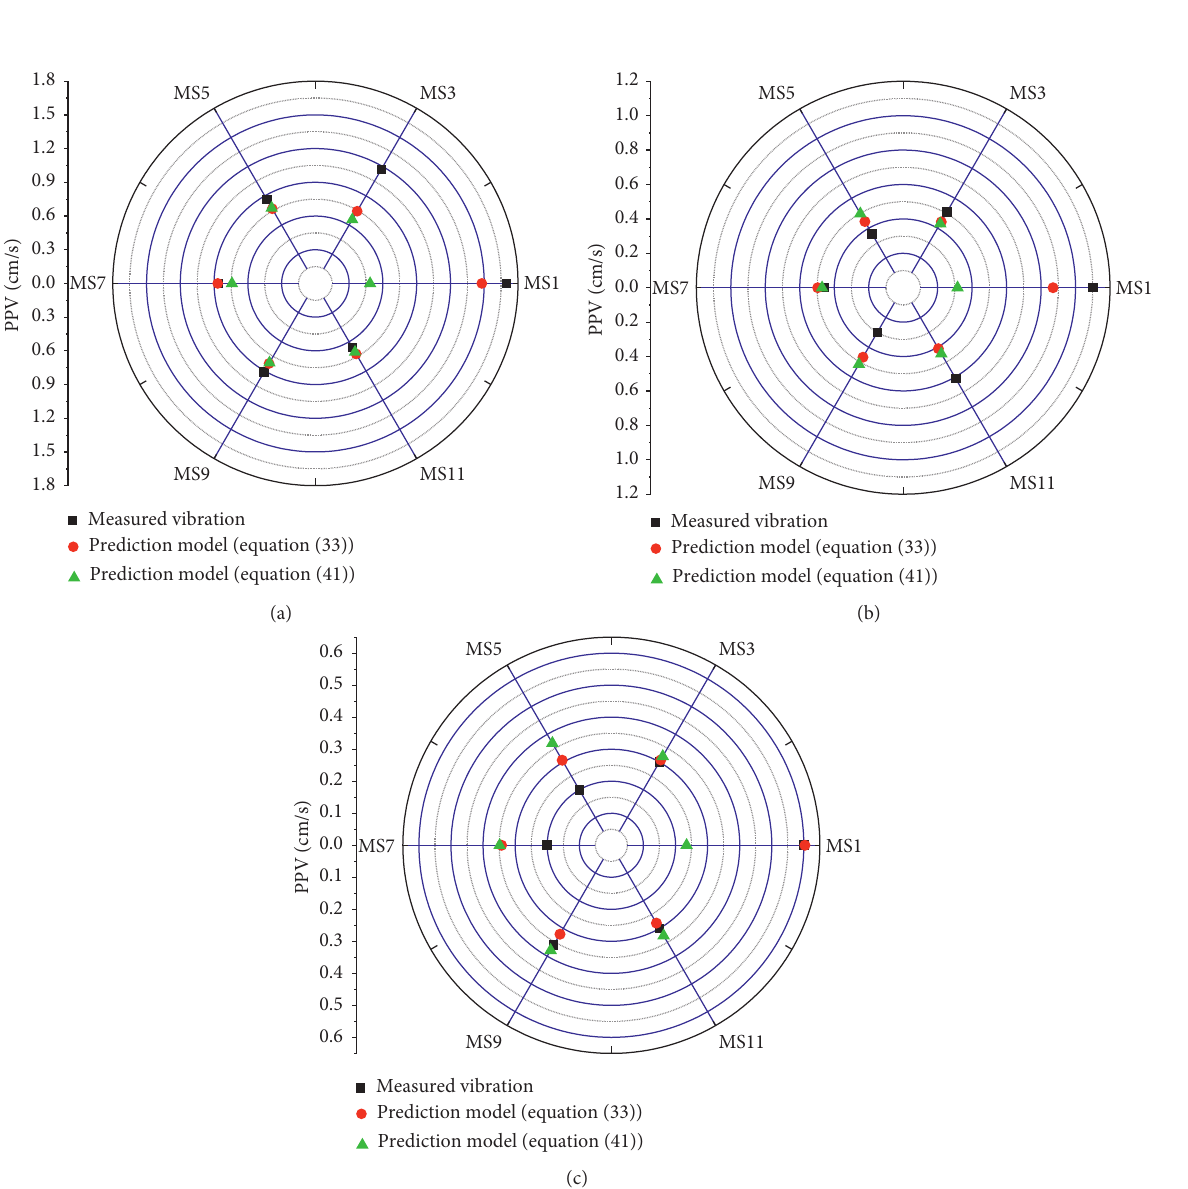
Figure 11: Comparison of predicted vibration and monitored vibration (in longitudinal). (a) Monitoring point #1. (b) Monitoring point #2. (c) Monitoring point